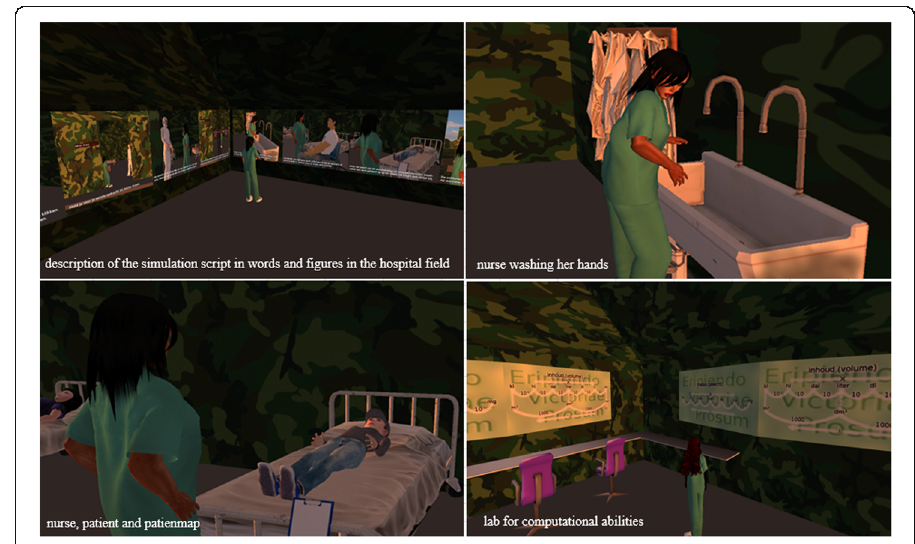
Fig. 1 Screenshots of the MASH learning